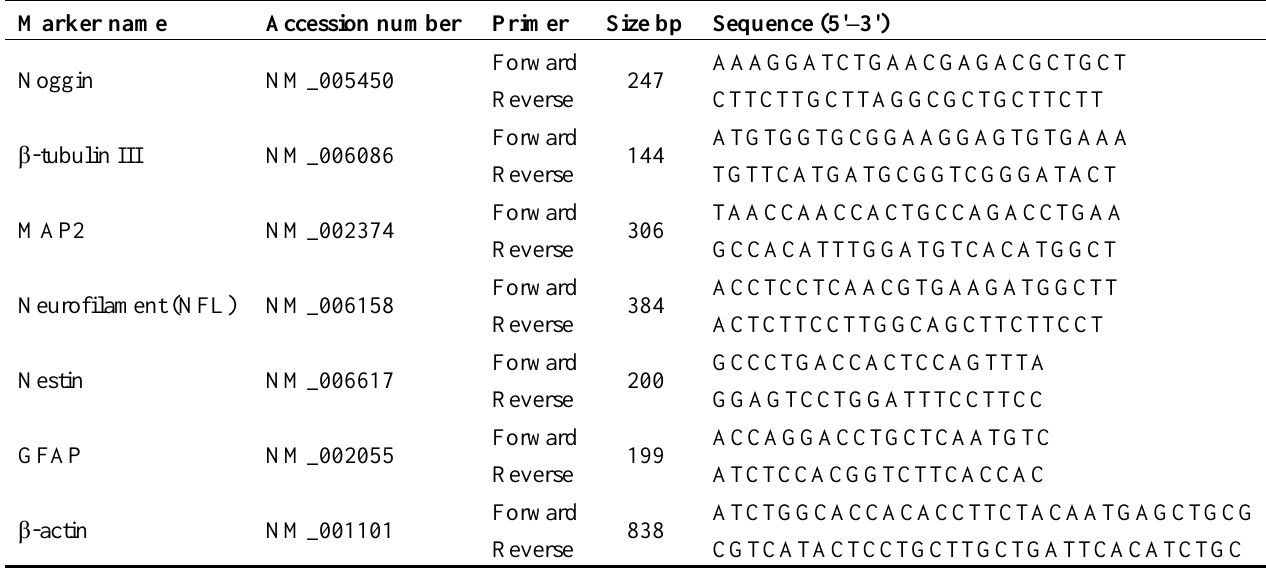
Table 1. List of primers used in mRNA expression